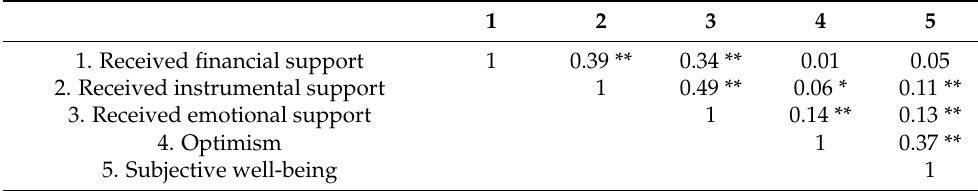
Table 2. Intercorrelations between variables in the theoretical